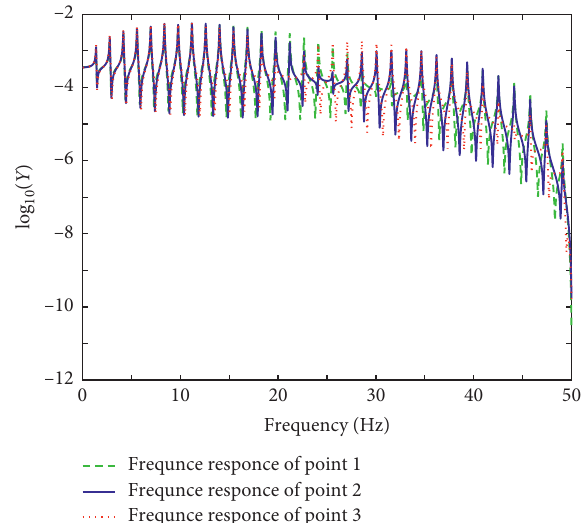
Figure 11: Frequency domain response diagram.